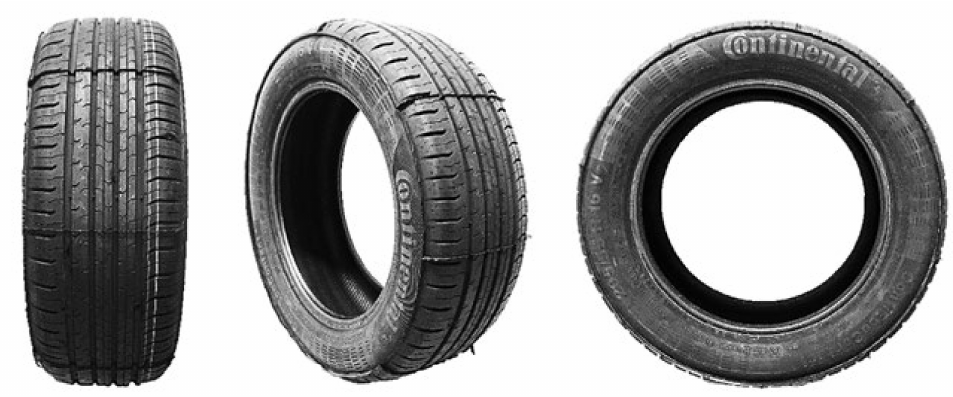
Figure 1. Object chosen for automated visual inspection methodology